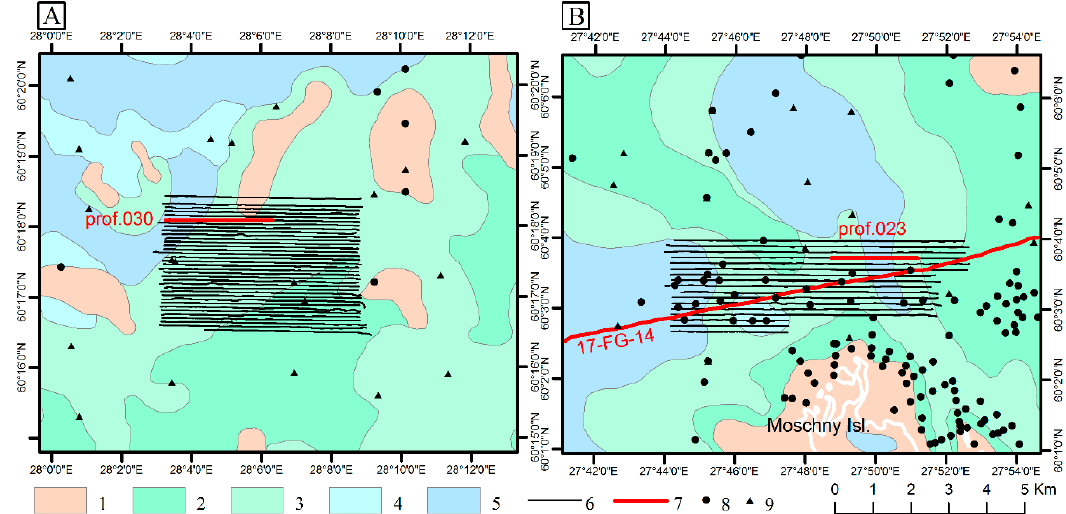
Figure 2. Part of a Quaternary deposits map of key study areas [14] with multibeam echosounder (MBES) and SBP profile tracks (solid black lines) and sampling stations (black dots). ( A ) Vyborg Bay; ( B ) Northern area off Moschny Island. Late Pleistocene sediment shown as (1) till; (2) varved clays; (3) homogenous clays of the Baltic Ice Lake. Holocene sediment shown as (4) Ancylus Lake clays, (5) Littorina—Post-Littorina marine silty-clayey muds. Geophysical data collection lines shown as (6) MBES and SBP (2017); (7) SBP, described in this article. Sample locations: (8) grab-corers and box-corers, (1984–2017); (9) long gravity corers (1984–2000).